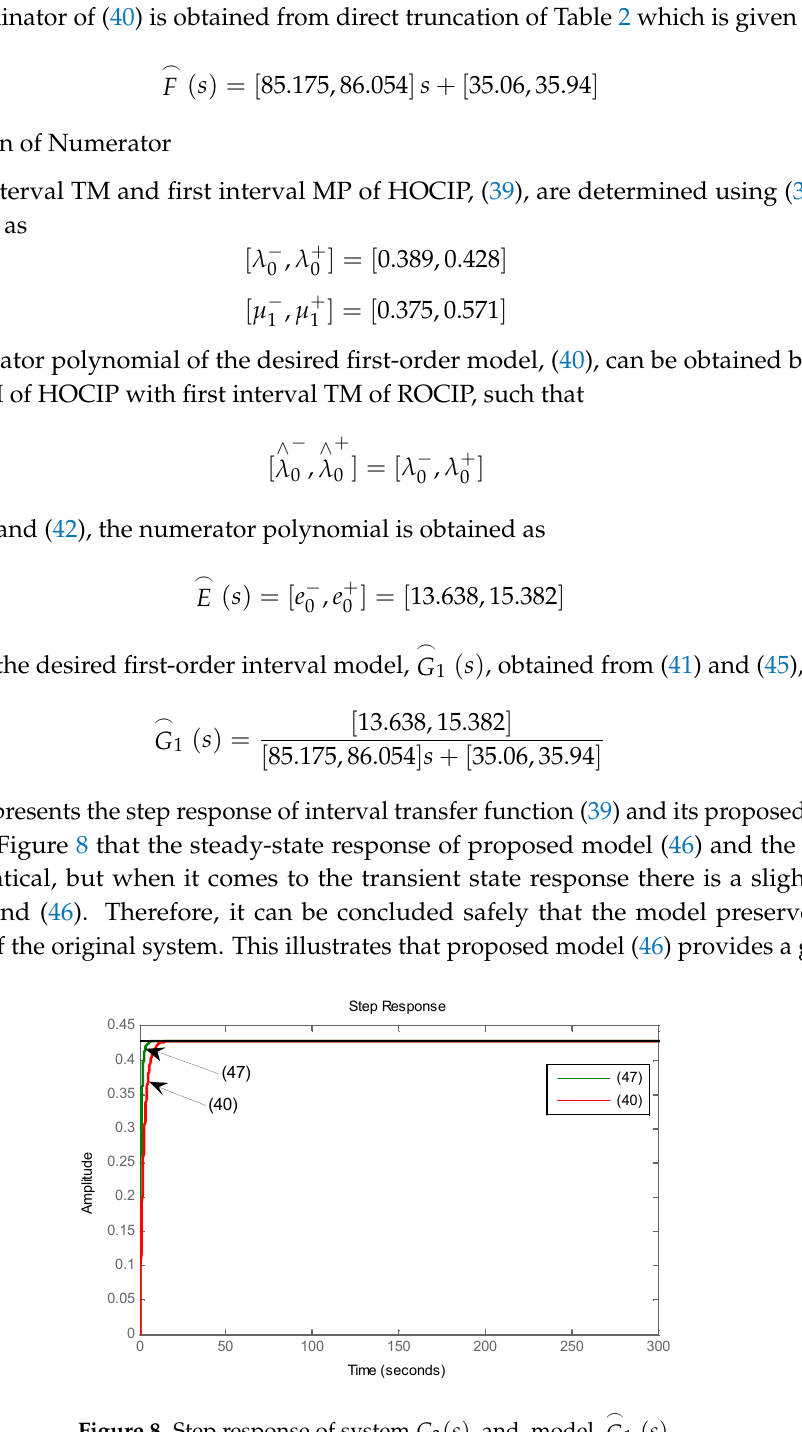
Figure 8. Step response of system G 3 ( s ) and model